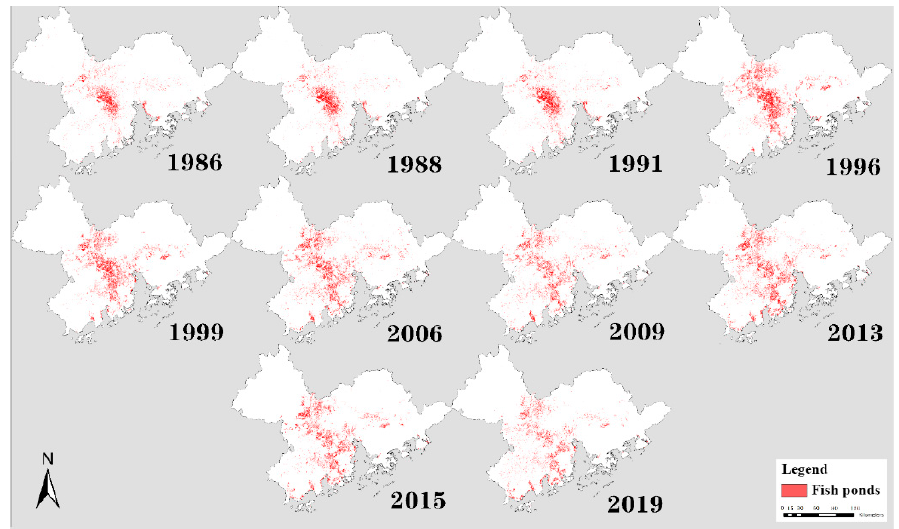
Figure 7. Spatial distribution of fish ponds in the GBA in the 10 different study periods.